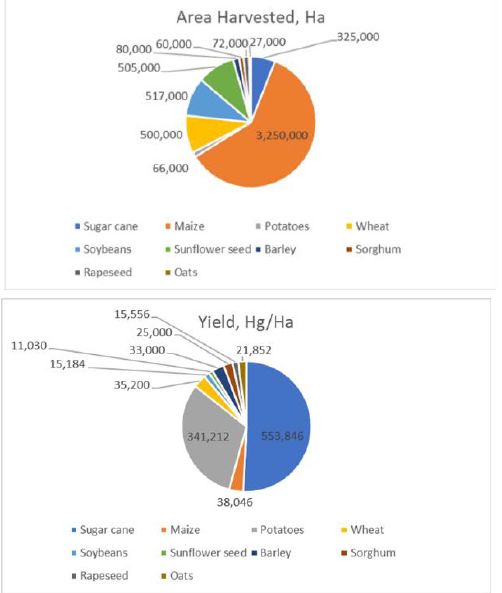
Figure 5: two pie charts showing crop (a) yield and (b) harvested in the study area in (Ha)